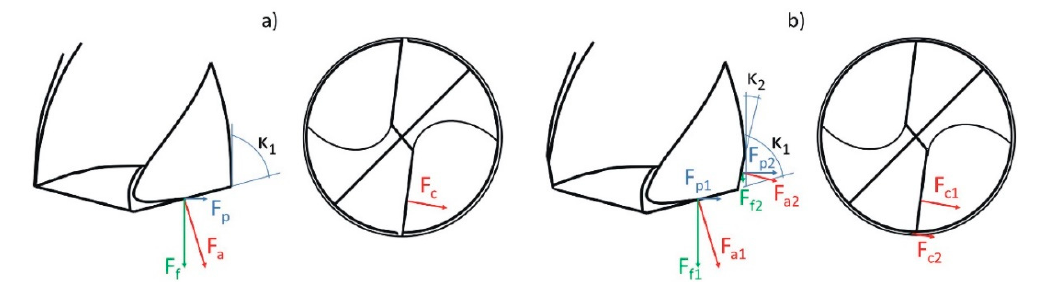
Figure 6. Components of cutting force for a factory ( a ) and modified ( b ) drills.